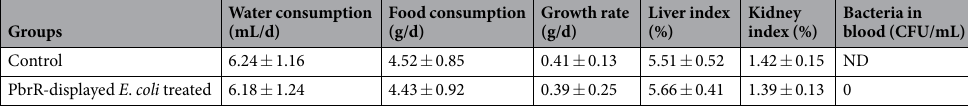
Table 1. Effect of 15 d PbrR-displayed E . coli treatment on mice. Liver index calculated as liver weight/body weight × 100%; kidney index calculated as kidney weight/body weight × 100%. Data were presented as mean values ± SEM (n = 10 per group). ND, not